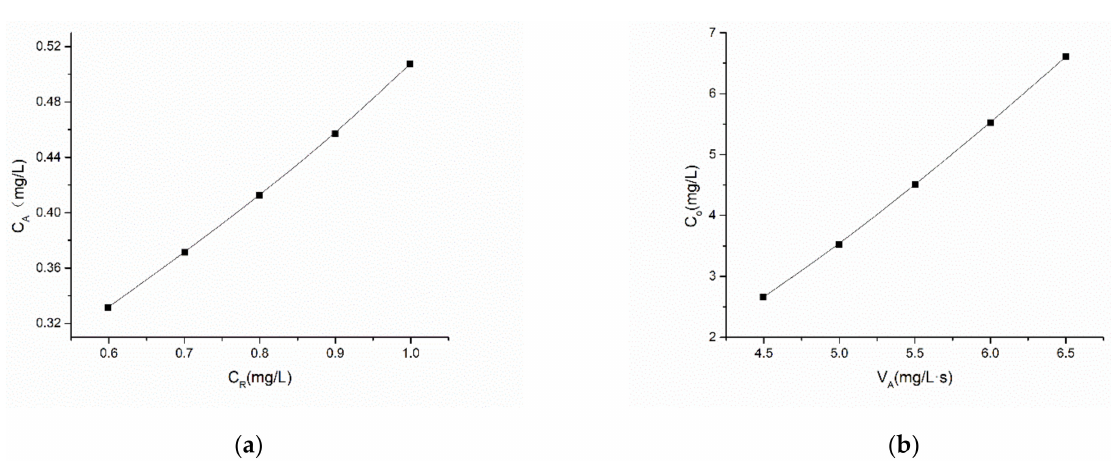
Figure 11. The relationship between the average DO concentration and the reflux slot and aerators. ( a ) Reflux slot; ( b )